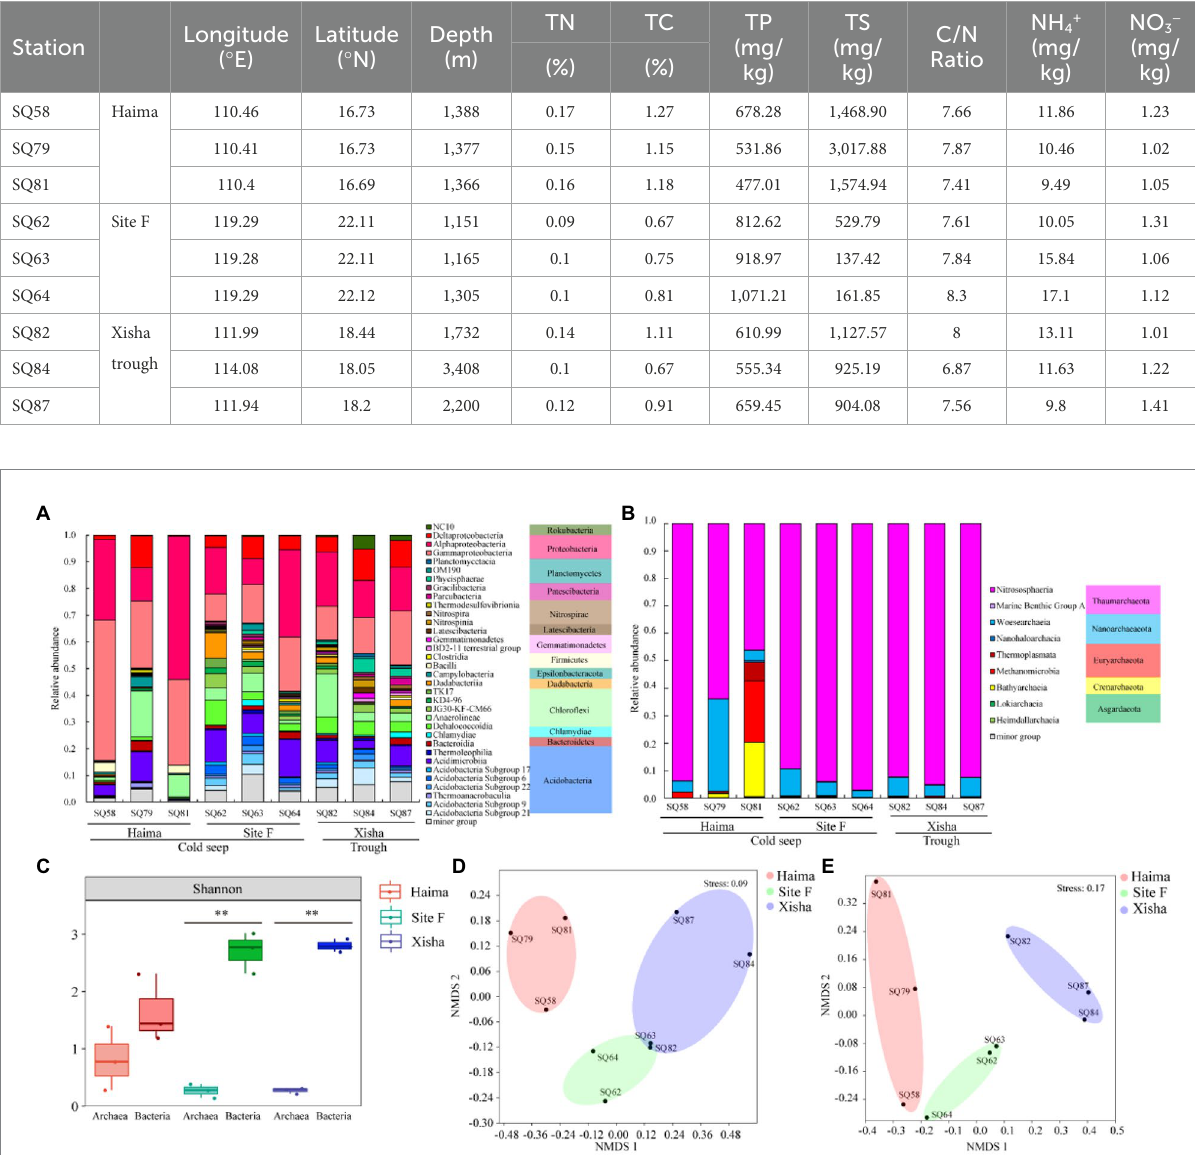
TABLE 1 Geochemical information of sediment samples collected from cold seeps in the South China Sea.